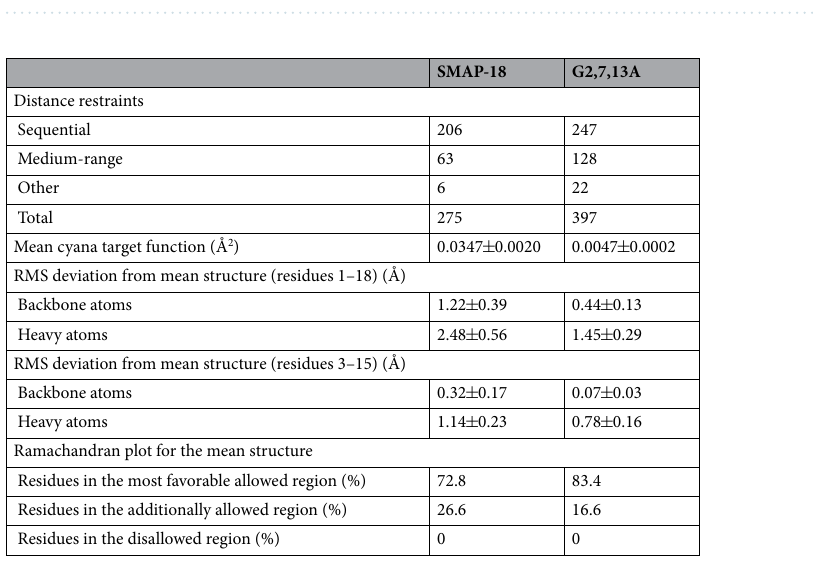
Figure 4. Sequential d αN ( i, i + 1 ) NOE connectivity for residues from 3 to 18 of SMAP-18 ( a ) and G2,7,13A analog ( b ).